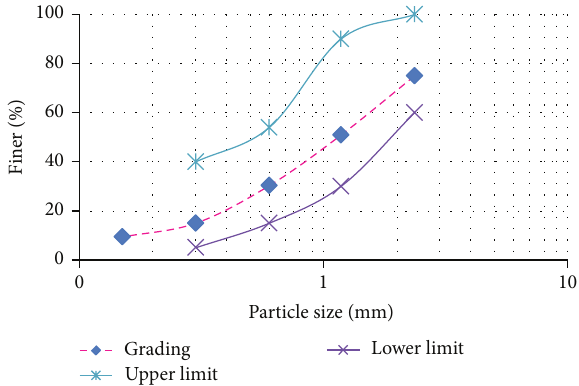
Figure 6: The particle size distribution of M-sand